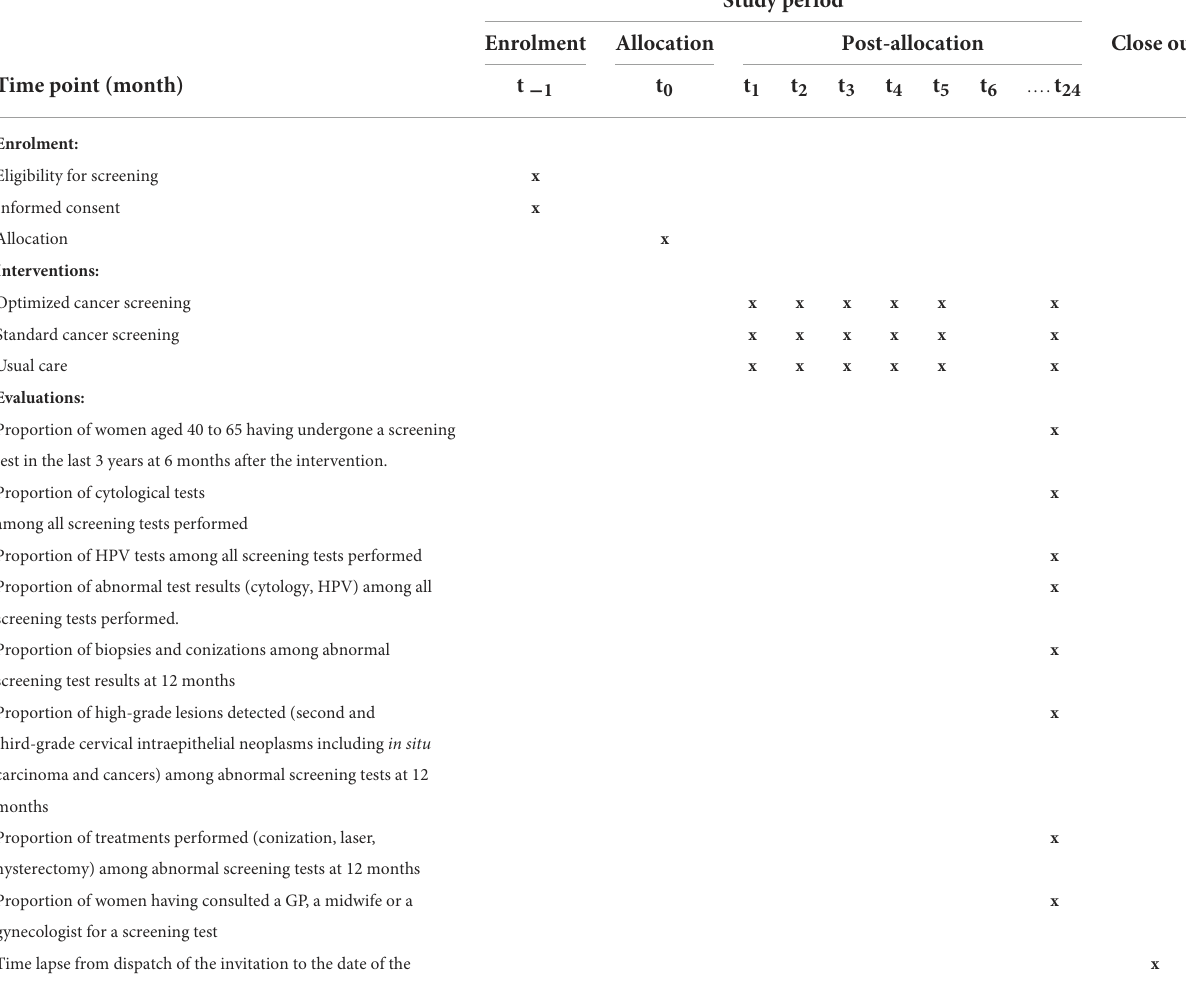
TABLE 2 Time schedule for enrolment, intervention, and assessments.